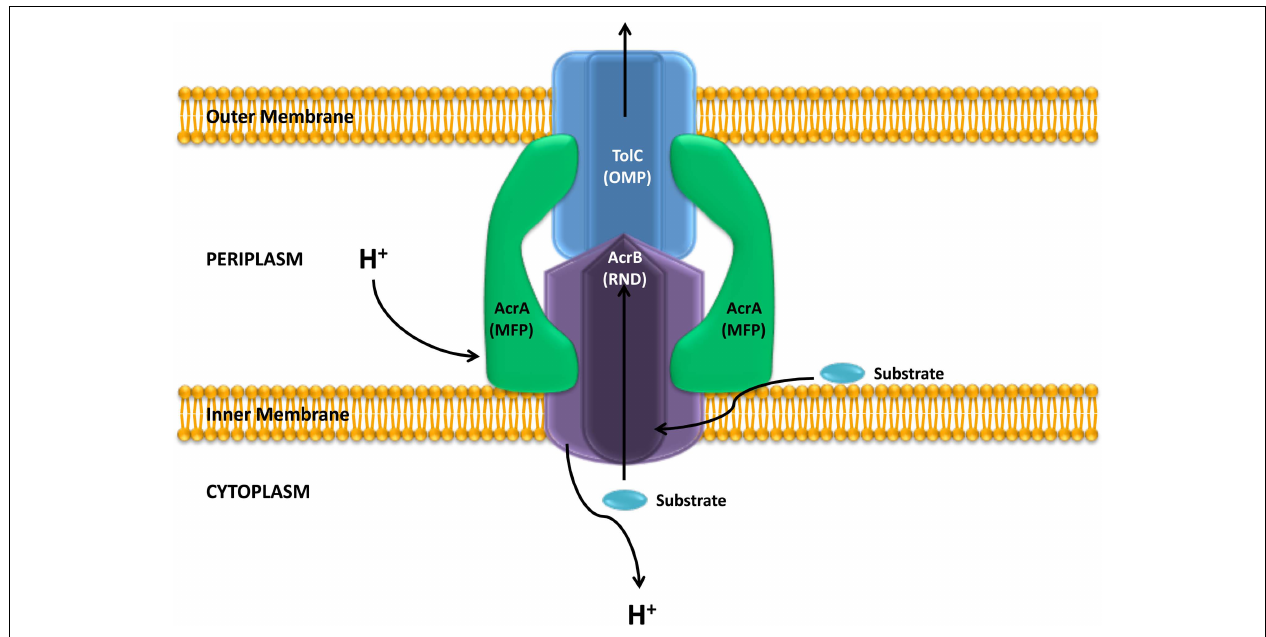
the AcrB RND protein is coupled to the proton gradient. It has been shown that these efflux pumps can extrude different compounds form the bacterial cytoplasm and the periplasm. Adapted from Blair and Piddock